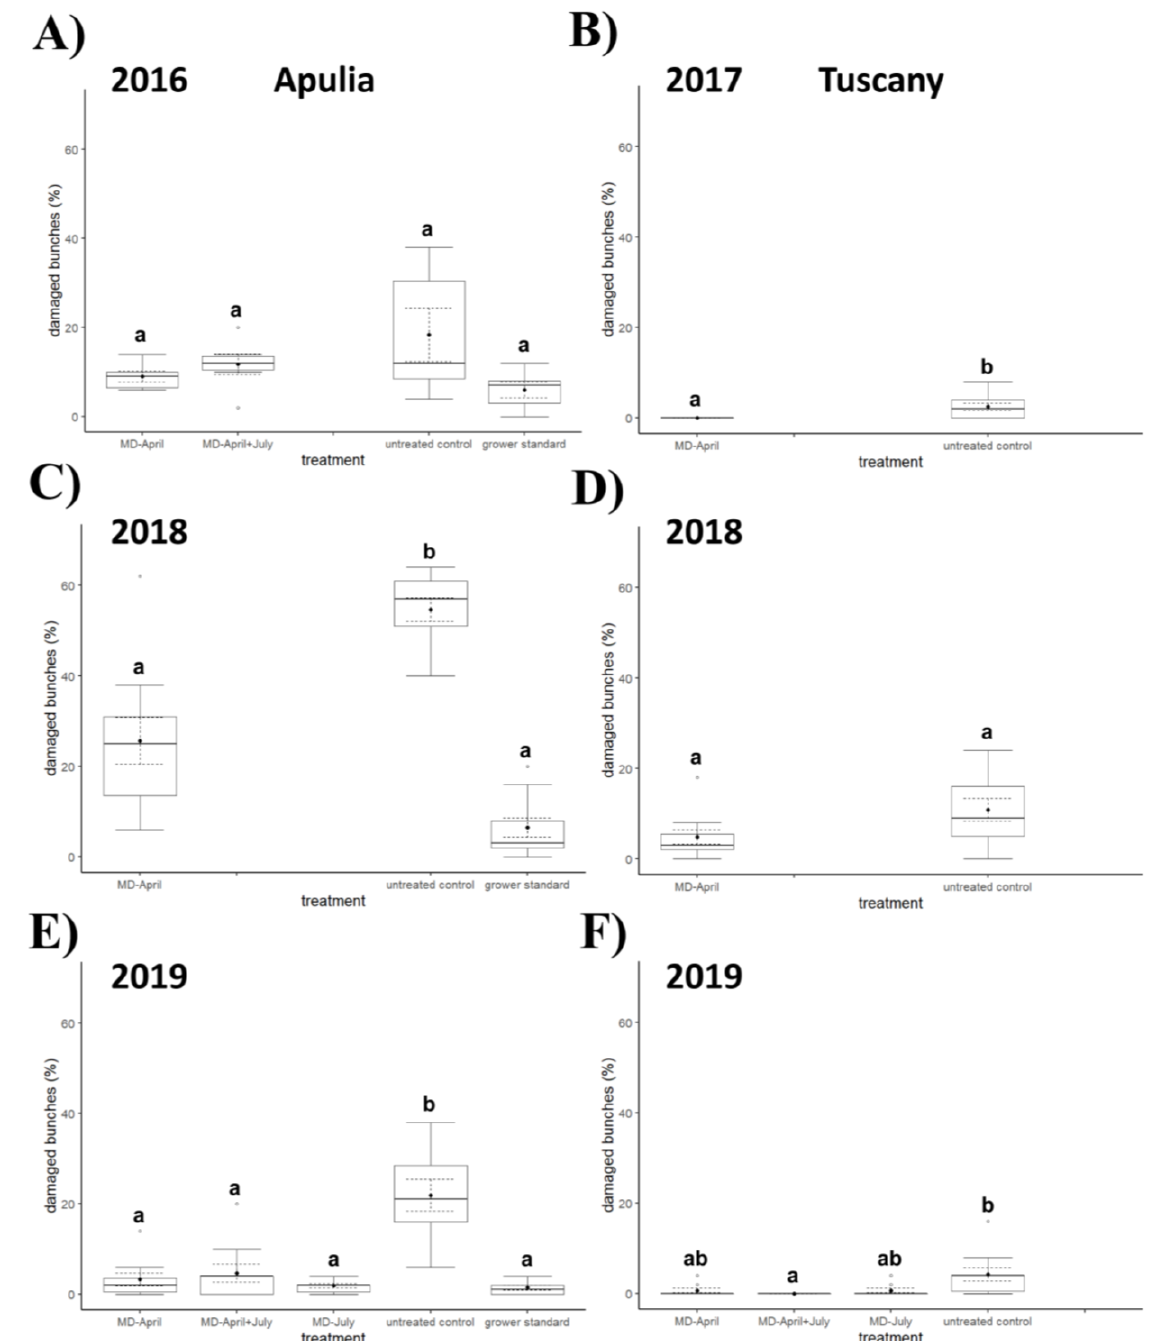
Figure 5. Impact of mating disruption (MD) using Isonet CGX111 dispensers on Cryptoblabes gnidiella infested bunches (%) among treatments and untreated control plots in Apulia ( A , C , E ) and Tuscany ( B , D , F ) during three-year samplings. Boxplots indicate the median (solid line) and the range of dispersion (lower and upper quartiles and outliers) of the parameter; black dot and dashed line indicate mean value and standard error, respectively. Different letters above boxplots indicate significant differences among treatments (Wilcoxon test for comparisons between two plots or Kruskal–Wallis test for multiple comparisons, the latter followed by Nemenyi post hoc test; p < 0.05).